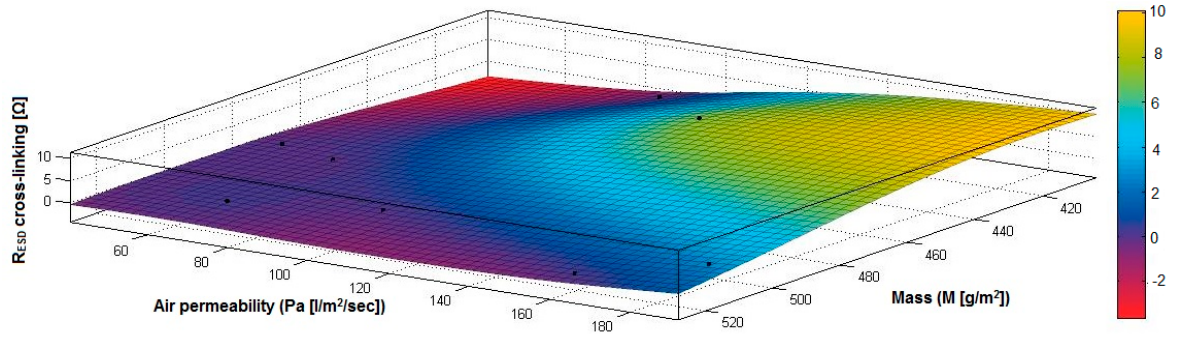
Figure 36. 3D representation R ESD after crosslinking = f(M, Pa) for samples preliminarily treated in RF plasma O 2 using RF 2 generator and power 100 W.